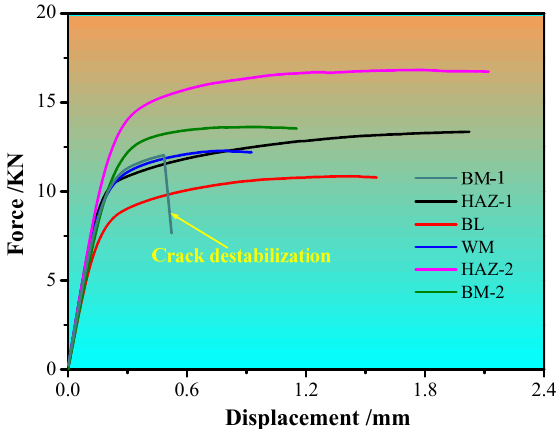
Figure 3. Force-displacement curves of six regions.